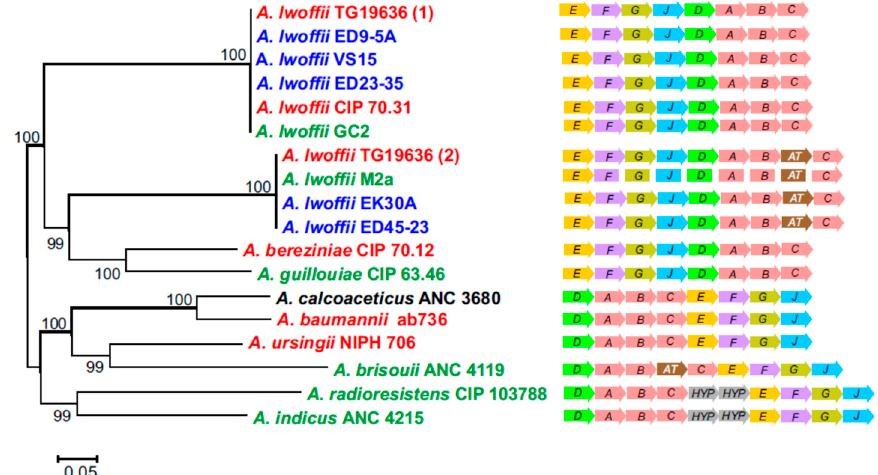
Figure 2. Structural organization and phylogeny of urease operon in Acinetobacter . The maximum likelihood phylogenetic tree was based on the concatenated amino acid sequences of eight proteins of the urease operon. Clinical, permafrost and other natural isolates of Acinetobacter are shown in red, blue and green, respectively. The origin of A. calcoaceticus AMC 3860 is unknown. AT, N-acetyltransferase gene; HYP, genes encoding hypothetical proteins.